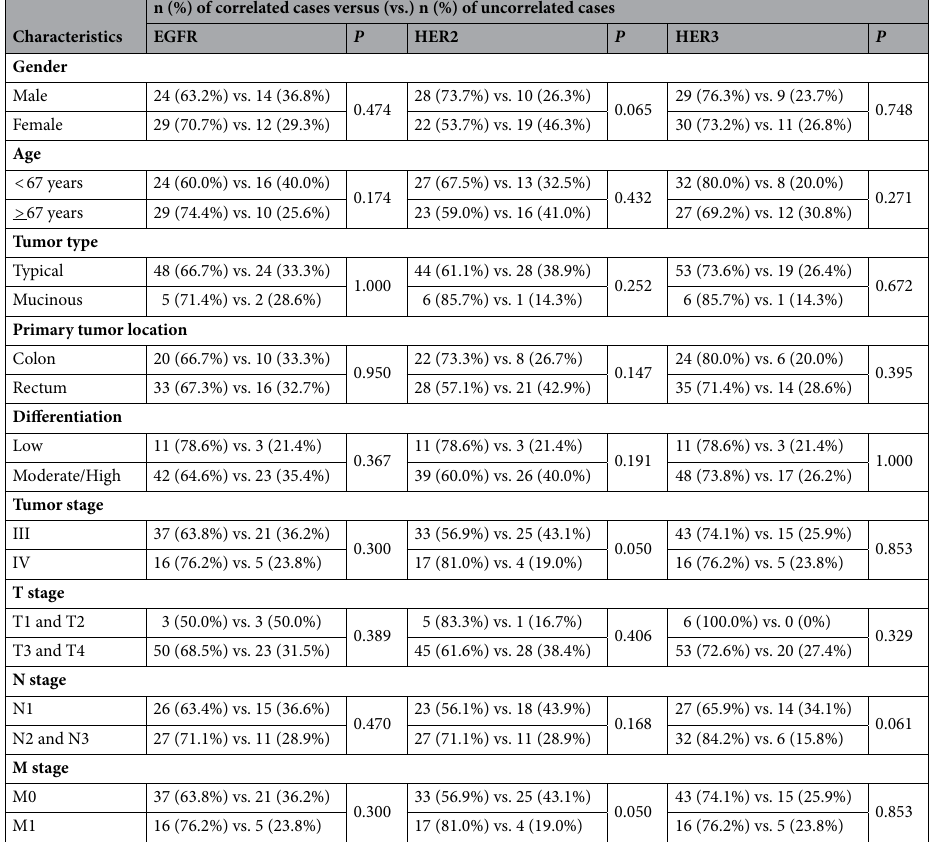
Table 3. Correlation between patient clinicopathologic characteristics and correlation rates of EGFR, HER2, and HER3 immunohistochemistry scores between primary lesions and lymph node metastases. A TNM classification system was used to define the tumor stage, T stage, N stage and M stage of the